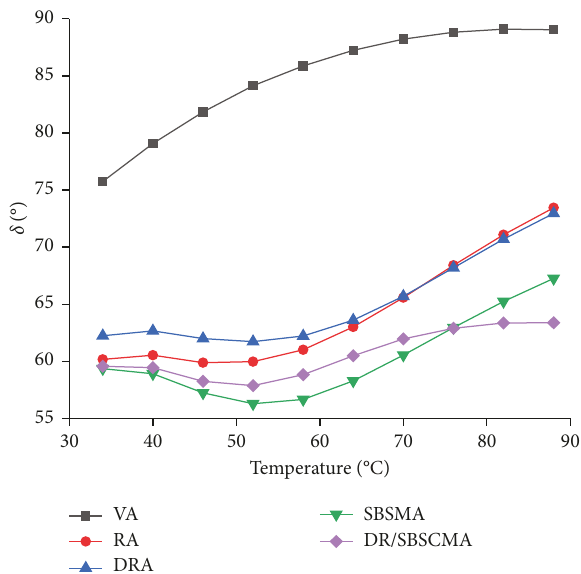
Figure 7: Relationship between the phase angle and